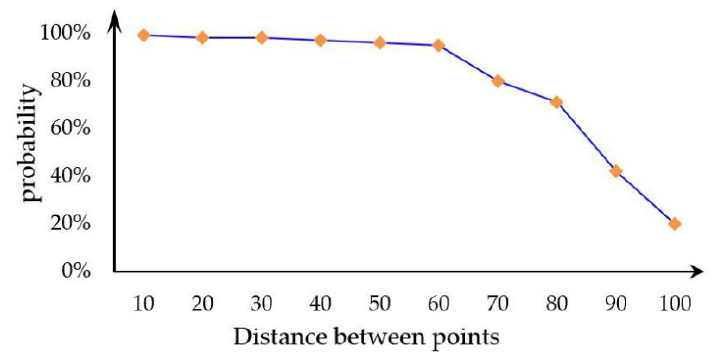
Figure 15. Threshold analysis of distance constraint.